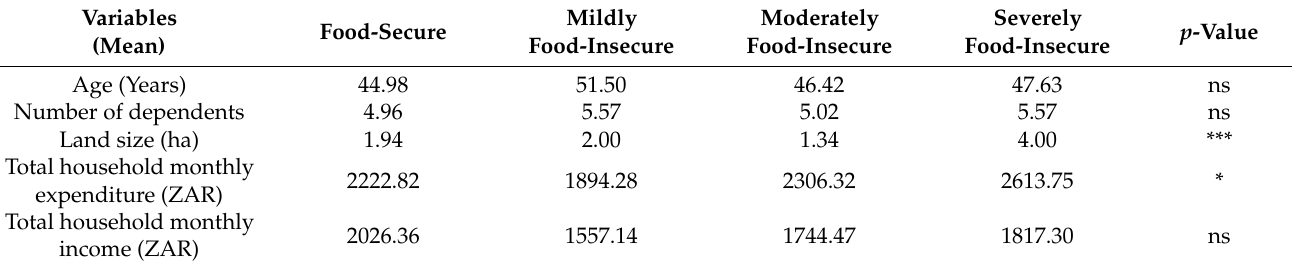
Table 2. Parametric One-Way ANOVA results for farmworkers’ food security